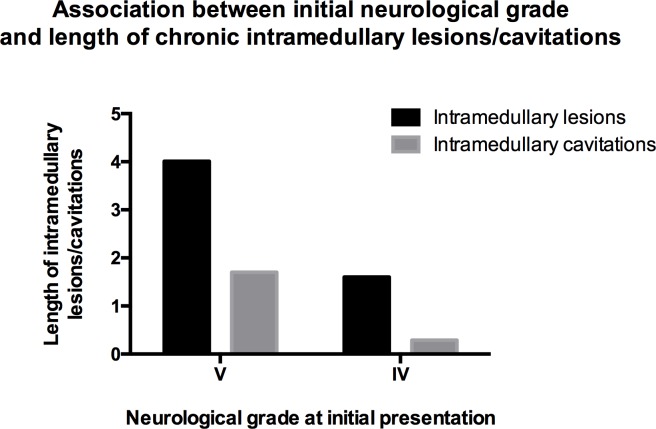
Association between length of chronic intramedullary lesions/cavitations and neurological grade following SCI (≤48 hours).Statistically significant difference between grade IV and V in regard to extension of intramedullary lesions (P = 0.002) and intramedullary cavitations (P = 0.008).